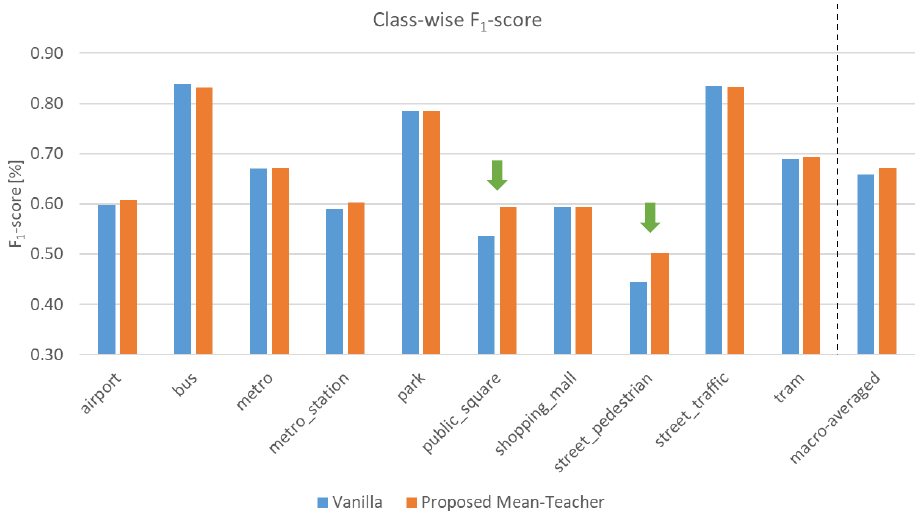
Figure 6. Classwise F 1 -score performances. Green arrows indicate classes with significantly improved F 1 -score